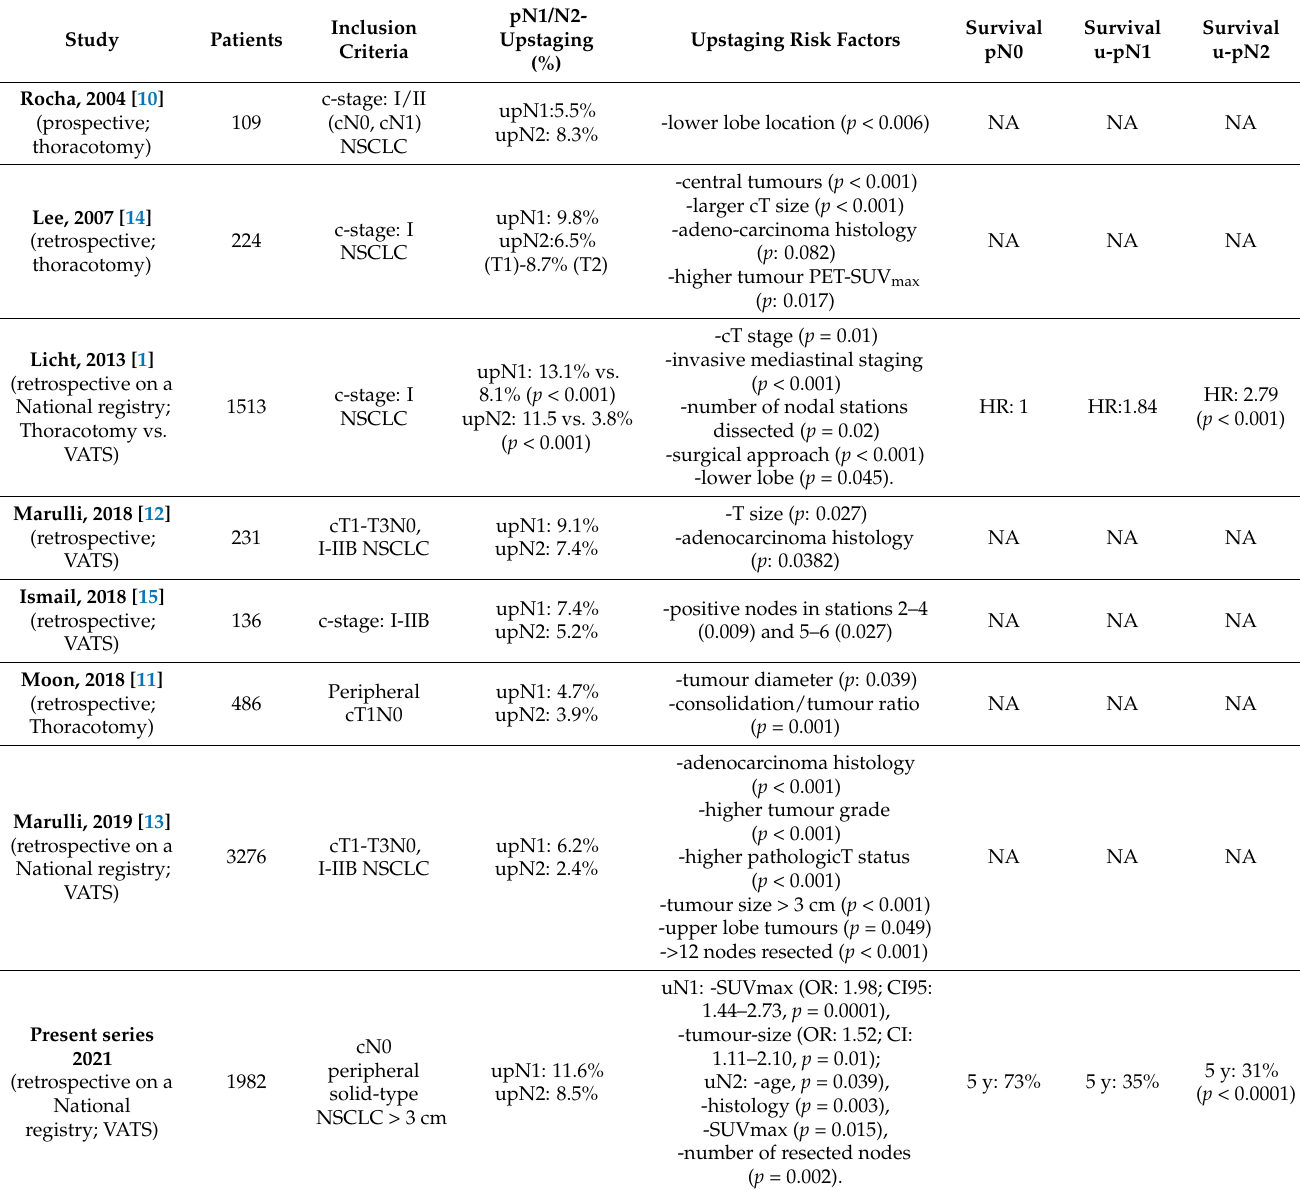
Table 4. An overview of studies on the nodal